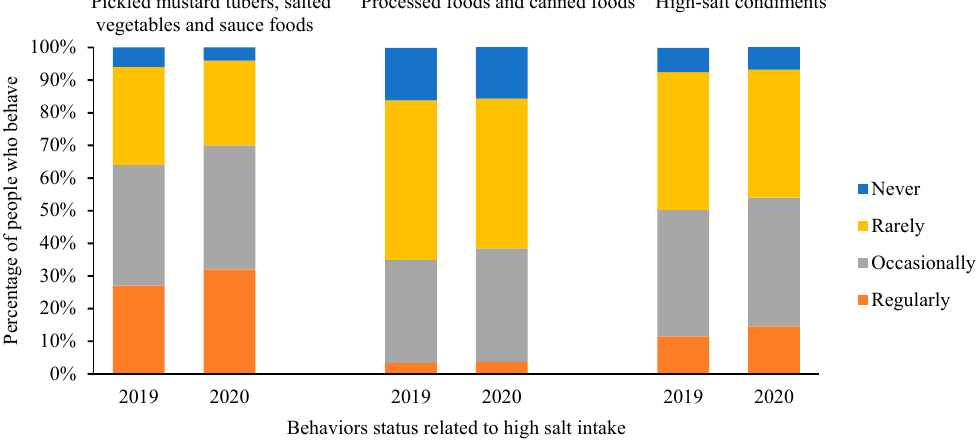
Figure 3. Comparison of behaviors status related to high salt intake between 2019 and 2020.